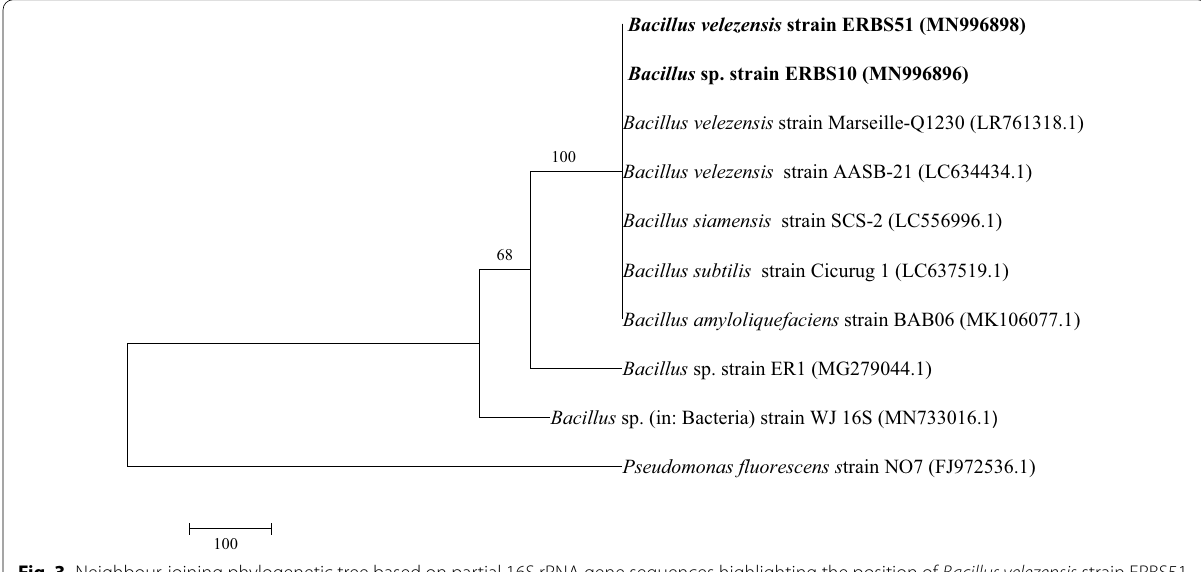
Fig. 3 Neighbour-joining phylogenetic tree based on partial 16S rRNA gene sequences highlighting the position of Bacillus velezensis strain ERBS51 and Bacillus sp. strain ERBS10 along with reference Bacillus strains retrieved from genbank. The numbers at the branches are bootstrap confidence percentages from 1000 bootstrapped trees. Pseudomonas fluorescens strain NO7 (FJ972536.1) was used as the out-group